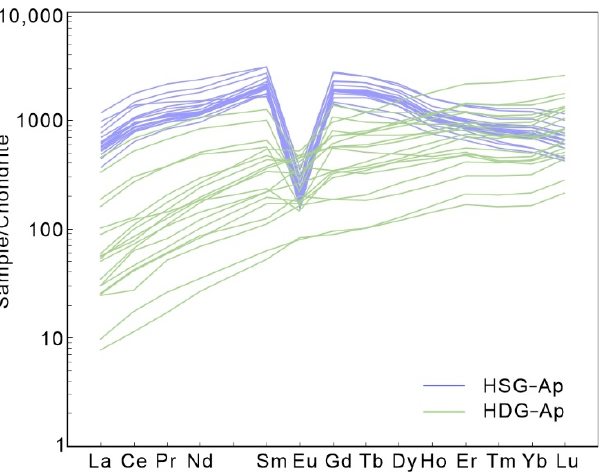
Figure 9. Chondrite ‐ normalized REE patterns of apatite from HSG and HDG. The chondrite REE Figure 9. Chondrite-normalized REE patterns of apatite from HSG and HDG. The chondrite REE values are from Sun and McDonough [87]. values are from Sun and McDonough